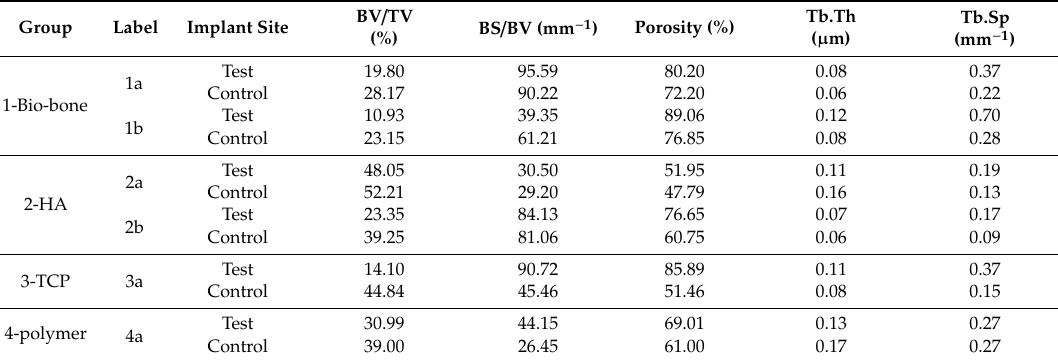
Table 3. Morphometrical parameters for each specimen in test and control site